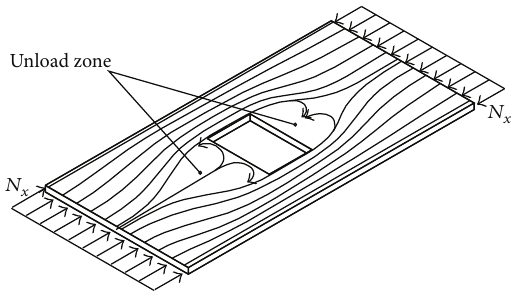
Figure 1: Redistribution of stress flow of plate with a hole.